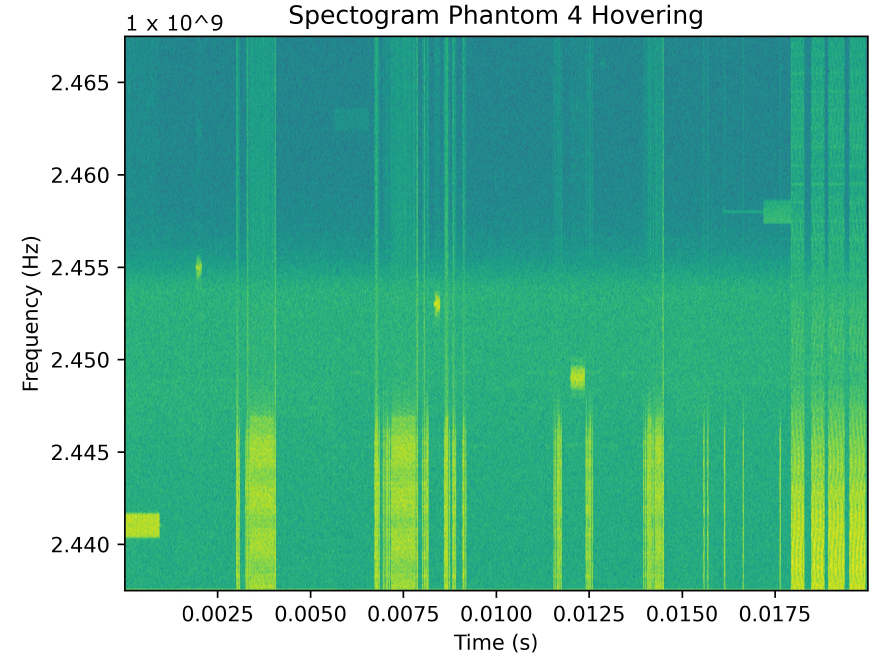
Figure 6. Spectrogram: Phantom 4